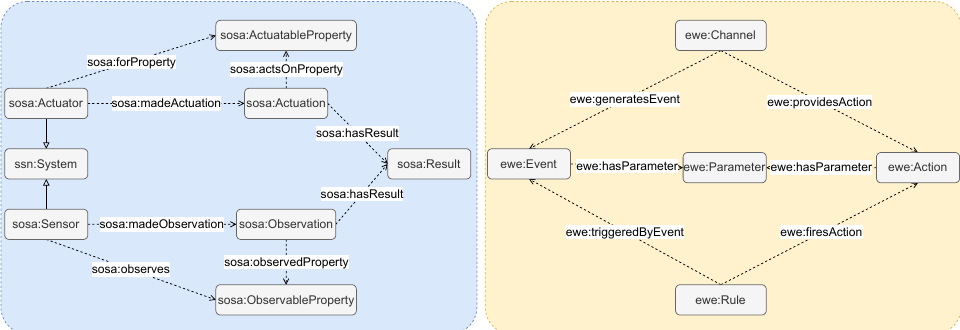
Figure 2. Main classes of SOSA and EWE